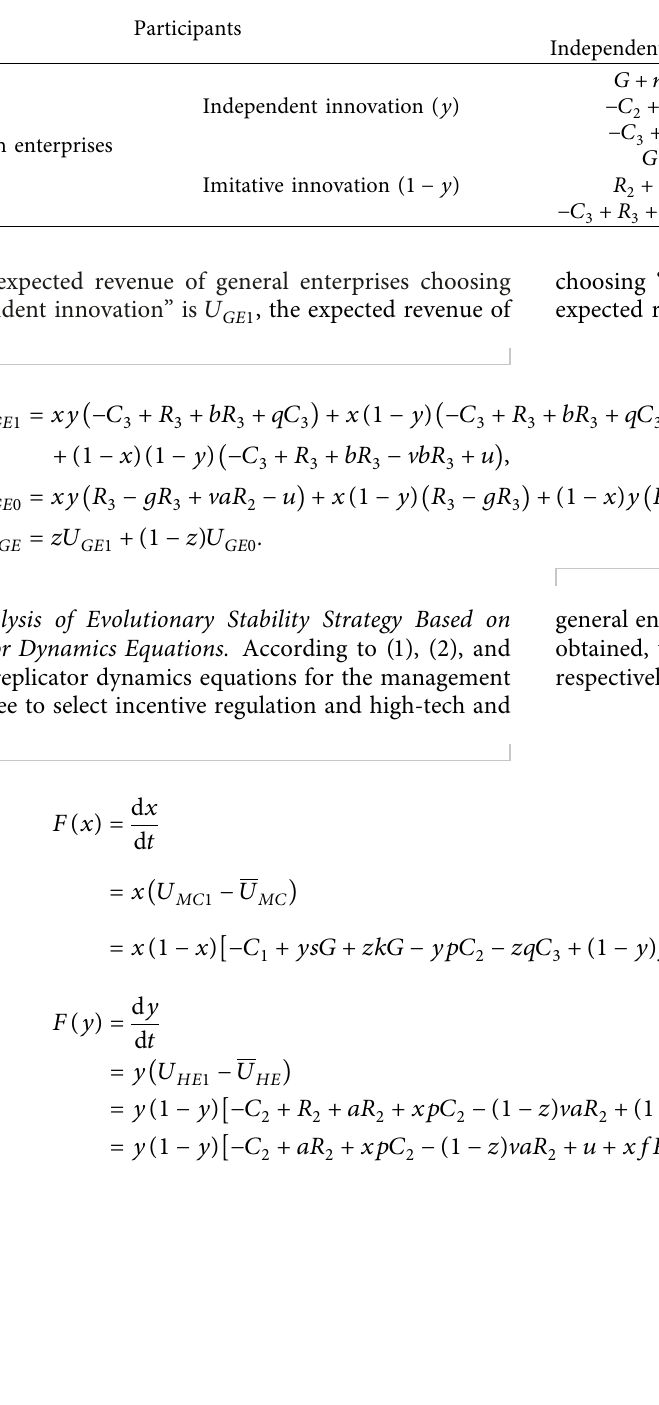
Table 2: Tripartite game payoff matrix when the management committee chooses “nonincentive